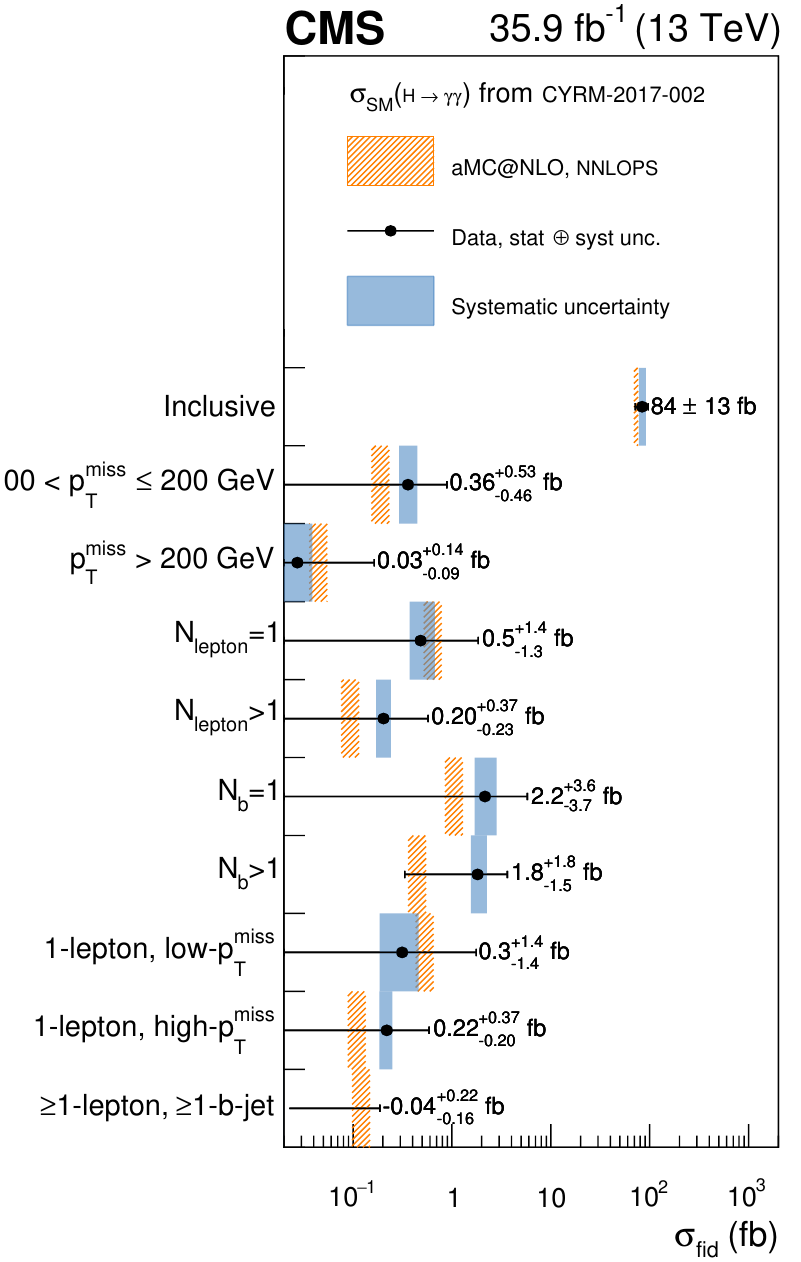
Figure 11 . The measurement of the di(cid:11)erential cross section (black points) for di(cid:11)erent regions of the phase space, listed on the vertical axis. The black error bars indicate the 1 standard deviation uncertainty and its systematic component is shown by the blue band. The measurements are found in agreement with the theoretical predictions (orange hatched area), normalized to the predictions from ref. [13]. The measured value of some of the cross sections is found to be compatible with the background-only hypothesis.